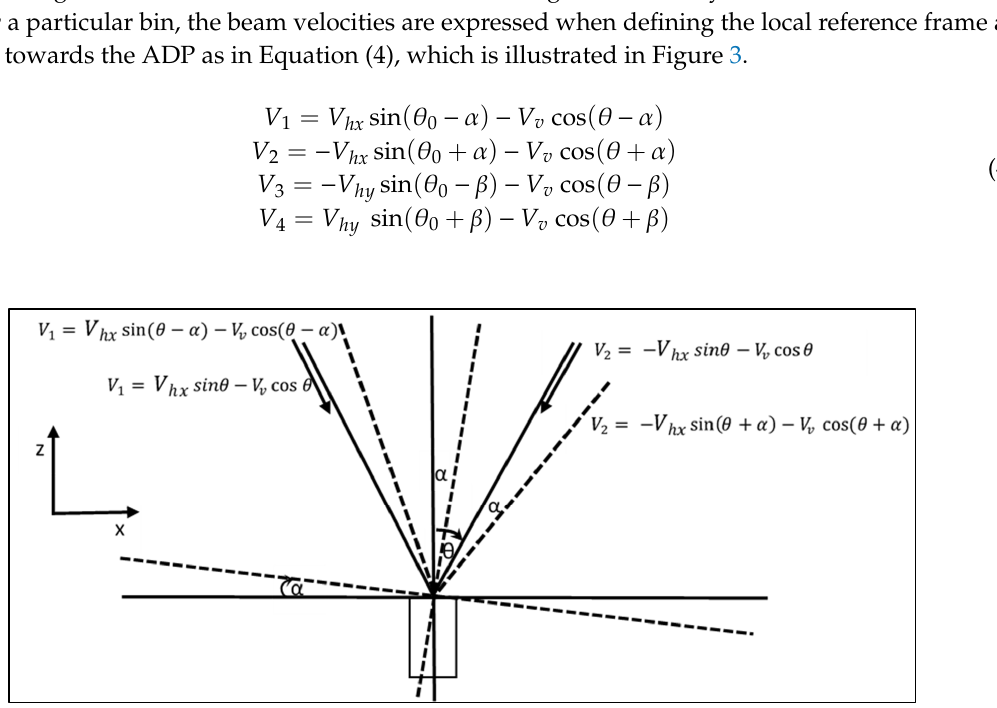
Figure 3. Schematic for movement of an ADP. Solid lines indicate before the movement condition and dashed lines indicate after α roll angle movement of ADP for beam 1 and beam 2.